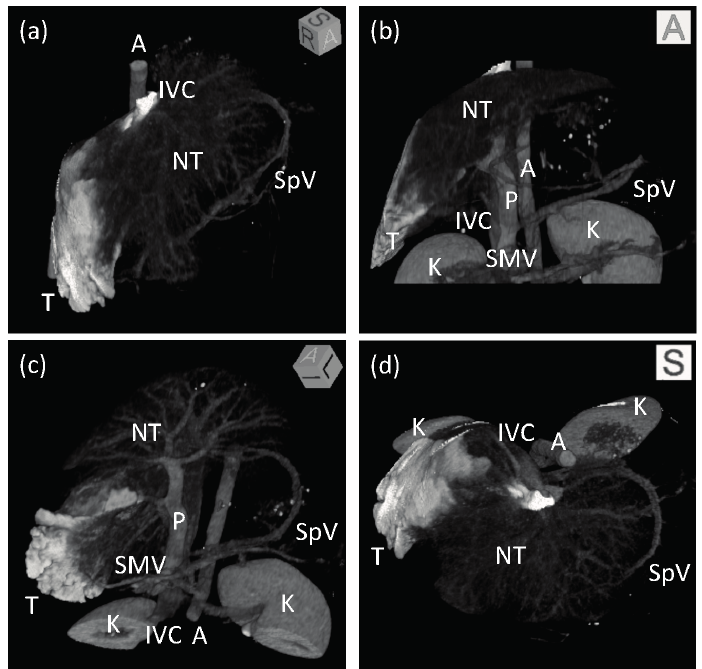
Figure 4. Three-dimensional images of the liver after regional hydrodynamic injection. Maximum intensity projection images after volume rendering viewing from the ( a ) right anterior superior, ( b ) anterior, ( c ) left anterior inferior, and ( d ) superior directions. The target area is shown in white. Branches of the hepatic and portal vein are visible in the non- target area of the liver. Boxes at the upper right corner of each image show an angle of 3D images. T: target area; NT: non-target area; IVC: inferior vena cava; P: portal vein; SpV: splenic vein; SMV: superior mesenteric vein; A: aorta, K: